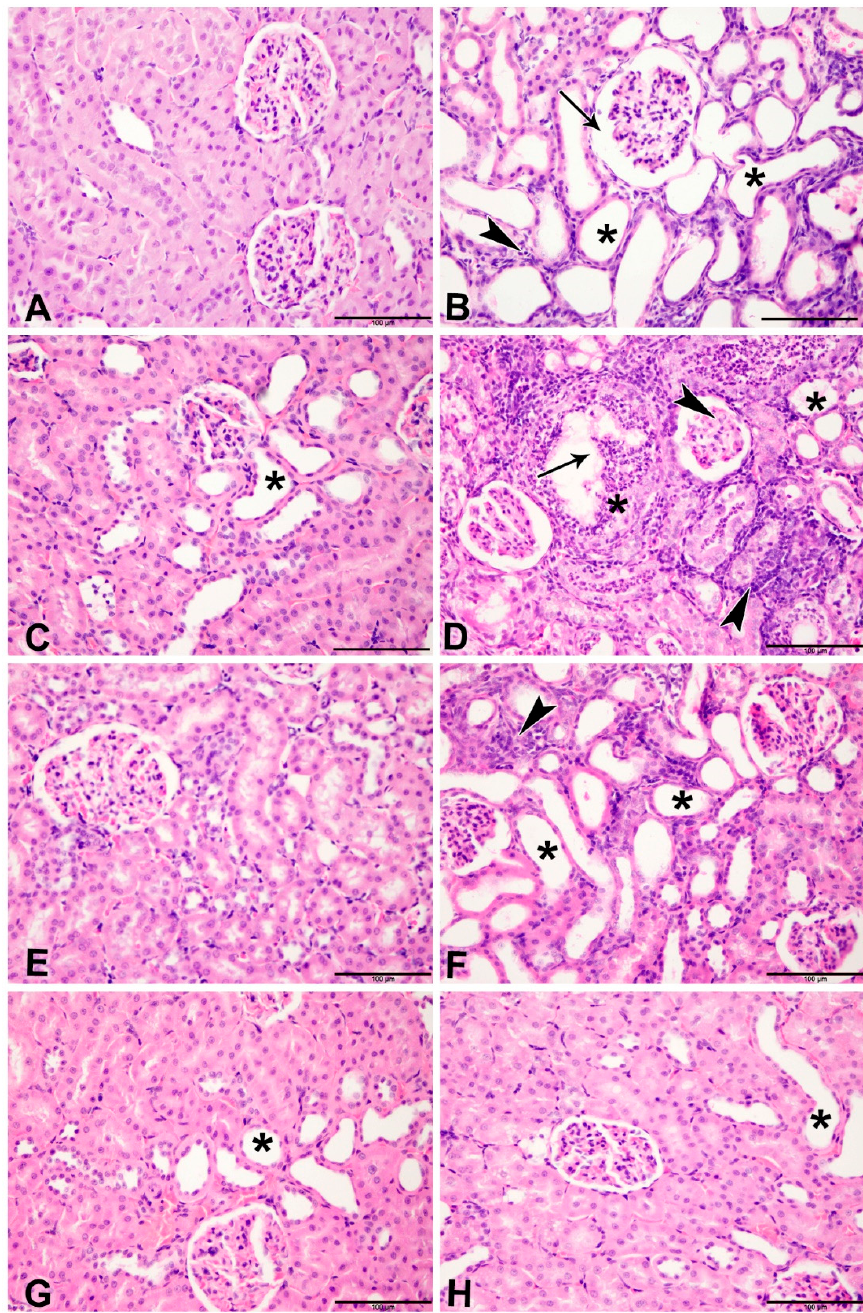
Figure 3. Representative light microscopy images of H&E-stained kidneys sections (Bar = 100 μ m). ( A ) Control group showing normal structures and architecture of renal tissue with intact glomeruli and renal tubules (Score 0); ( B ) rats treated with adenine (A) showing cystic dilatation of multiple renal tubules (asterisks), renal tubular necrosis with pyknotic nuclei (arrowheads), marked basophilia, and dilatation of bowman’s capsule (arrow) (Score 4); ( C ) rats treated with streptozotocin (STZ)-induced diabetes showing group cystic dilation of few renal tubules (asterisk) (Score 2); ( D ) rats treated with adenine and STZ showing, renal tubular necrosis (arrowheads), cystic dilatation of renal tubules (asterisks), and cellular casts in renal tubules (arrow) (Score 4); ( E ) rats treated with metformin (MF) showing normal glomerulus and renal tubules (Score 0); ( F ) rats treated with adenine and MF showing renal tubular dilatations (asterisks) and tubular necrosis with marked basophilia (arrowhead) (Score 3); ( G ) rats treated with STZ and MF showing normal histological structures of the majority of the renal tubules, intact glomeruli and few dilated tubules (asterisk) (Score 1); ( H ) rats treated with adenine, STZ and MF showing normal renal tubules and intact glomeruli with few dilated tubules (Score 0).